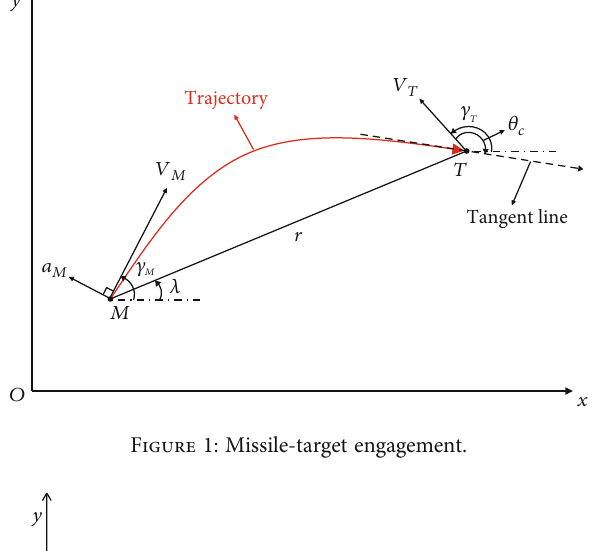
Figure 1: Missile-target engagement.